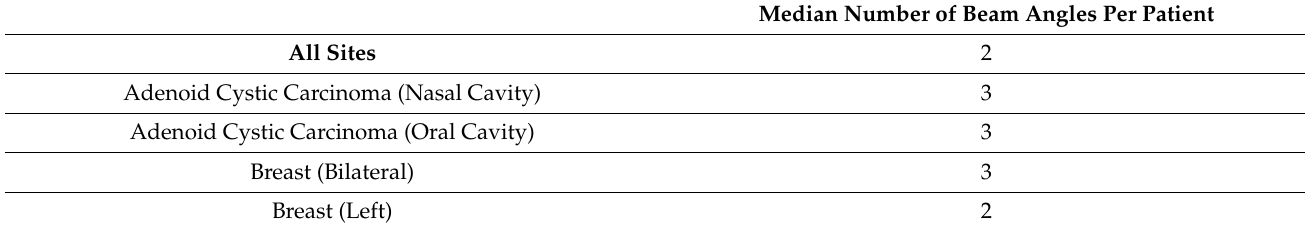
Table 3. Median number of beam angles per patient by treatment